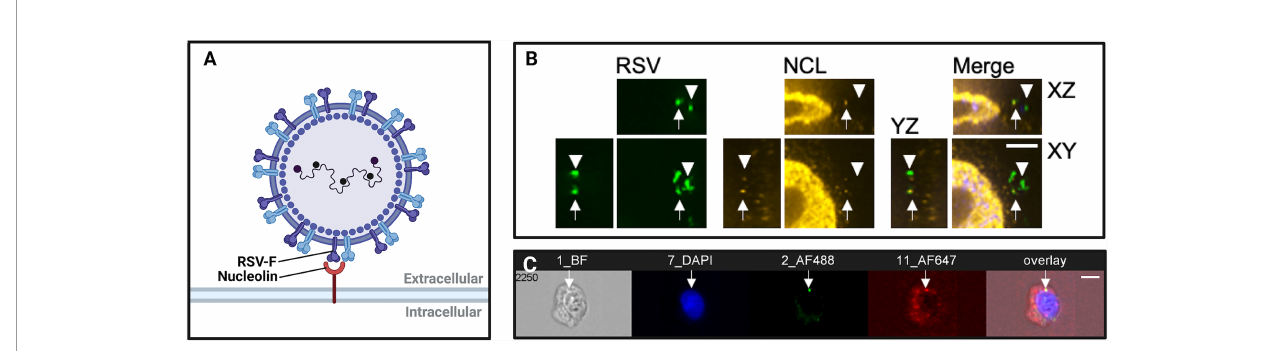
FIGURE 1 | Imaging virus-receptor interactions using confocal microscopy and imaging fl ow cytometry. (A) Schematic representation of respiratory syncytial virus (RSV) binding to nucleolin, an RSV co-receptor, imaged in (B, C) . (B) Confocal immuno fl uorescence microscopy of bronchial cells, showing RSV (green), nucleolin (red). Arrows show RSV particles localized to nucleolin, demonstrating typical nucleolin “ patching ” during RSV infection. Arrowheads denote RSV virions that are not bound to a receptor, and do not co-localize with nucleolin. Scale bar = 6mm. (C) Imaging fl ow cytometry (Imagestream) of RSV and nucleolin. Shown is a representative image out of approximately fi fty-thousand recorded events per sample. The overlap of green (RSV) and red (nucleolin) channels was quanti fi ed post- acquisition by a user-speci fi ed algorithm that determined thresholding and then mask overlap of virus-receptor overlap events. We have found that these ‘ overlap events ’ detected by imaging fl ow cytometry corresponded to RSV glycoprotein binding to nucleolin as determined by co-immunoprecipitations, anti-receptor antibody infection neutralization assays, and af fi nity analysis of recombinant RSV-F glycoprotein and